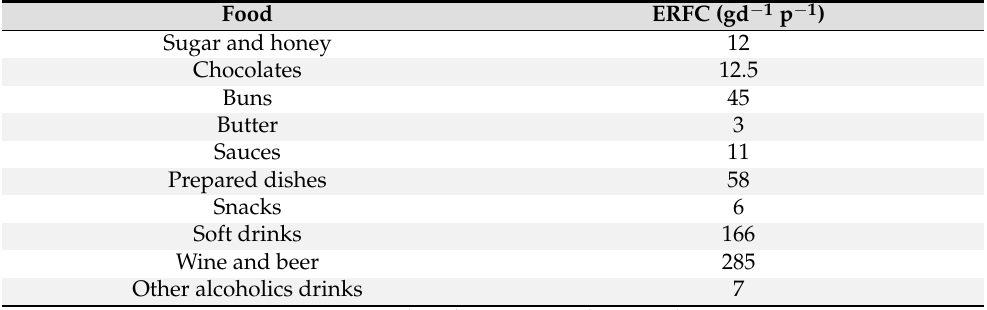
Table 2. Consumption of foods recommended to be consumed occasionally.